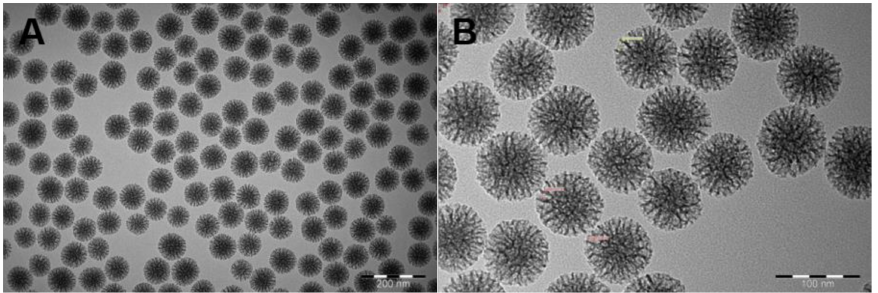
Figure 2. TEM images of MSNs. Images show size and structure uniformity and readily dispersed particles. Scale bars: ( A ) 200 nm, ( B ) 100